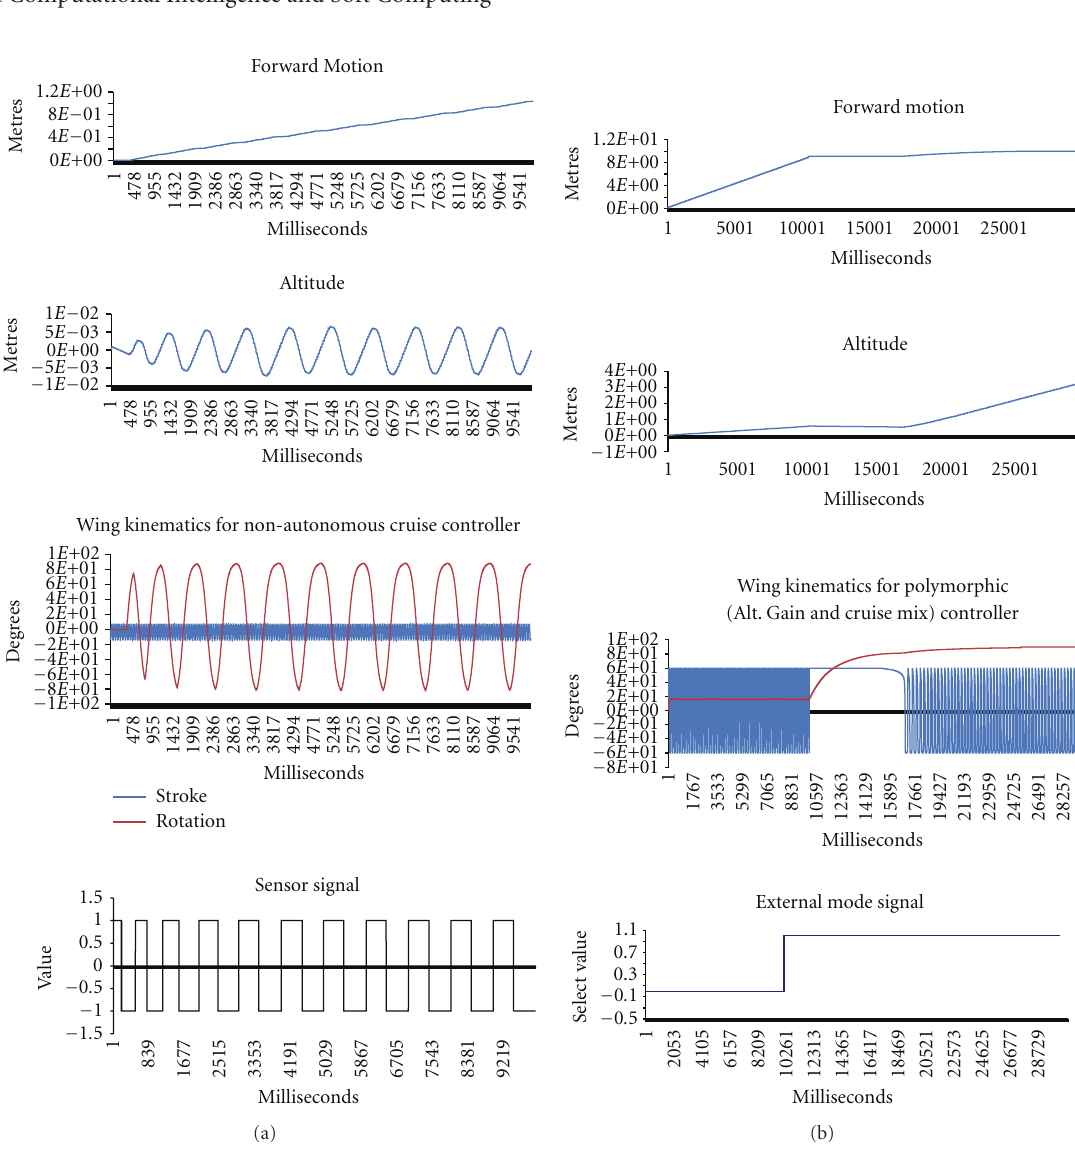
Figure 7: (a) shows the Wing Kinematics generated by the Central Core network of a Non-Autonomous Cruising Controller and the corresponding insect motion and sensory update (the stroke kinematics relatively has higher beats rate than that in rotation for the above controller). (b) shows the Wing Kinematics generated by the Central Core network of a Polymorphic flight Controller and the corresponding insect motion, when acted upon by external sensory inputs. One can see the initial cruising behavior is been switched to Alt. Gain behavior (with brief switching delay in wing